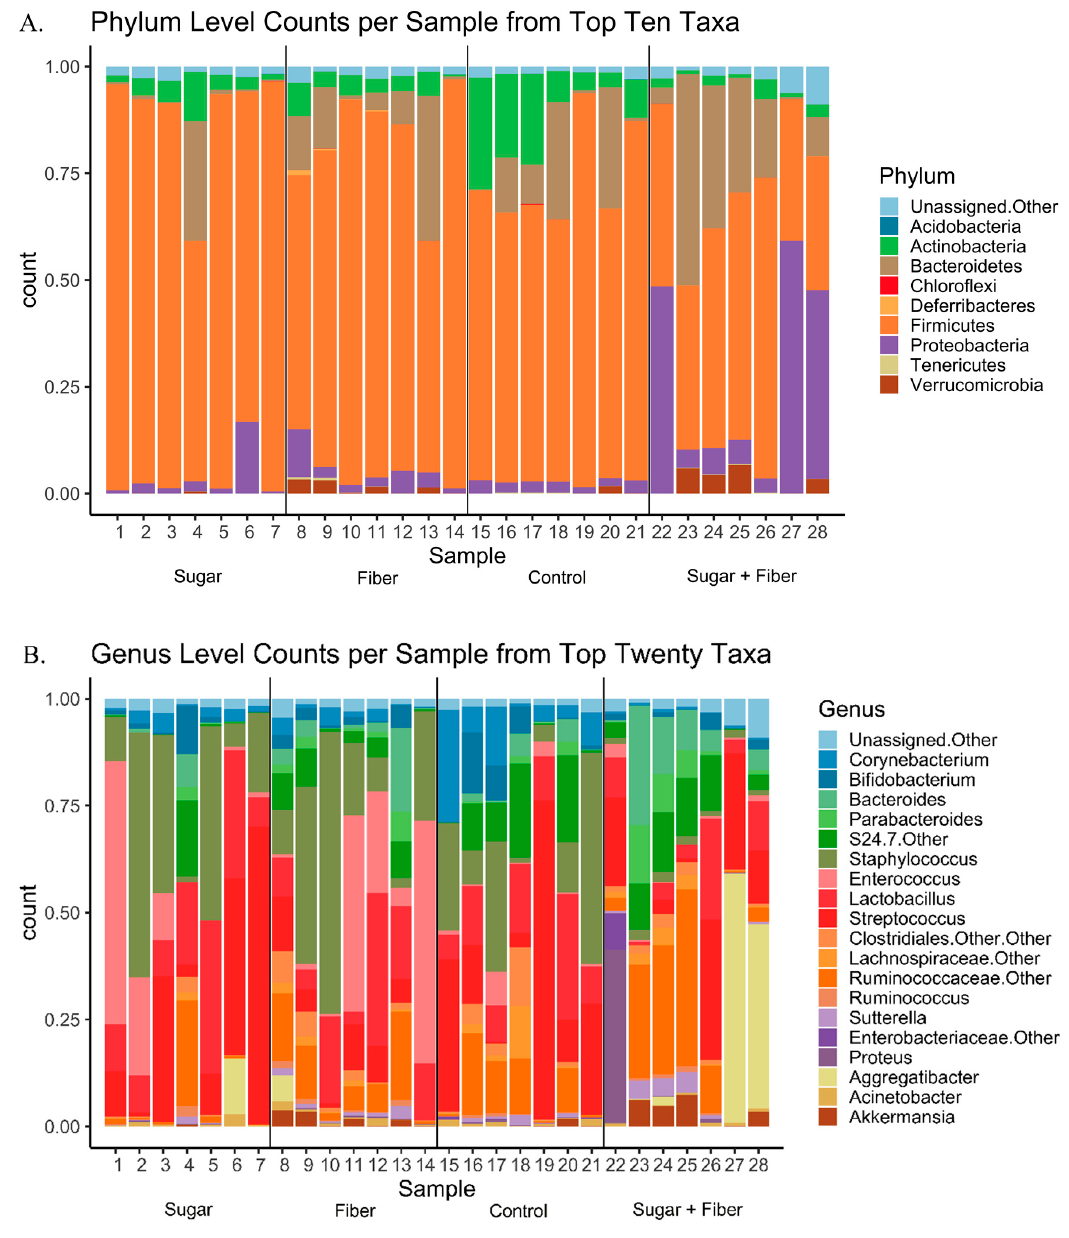
Figure 1. Stacked bar charts of major taxon relative abundance by sample. Sample numbers are associated with the following diet groups: 1–7 (Sugar), 8–14 (Fiber), 15–21 (Control), 22–28 (Sugar + Fiber). ( A ) Taxonomic level of phylum; ( B ) Taxonomic level of genus.